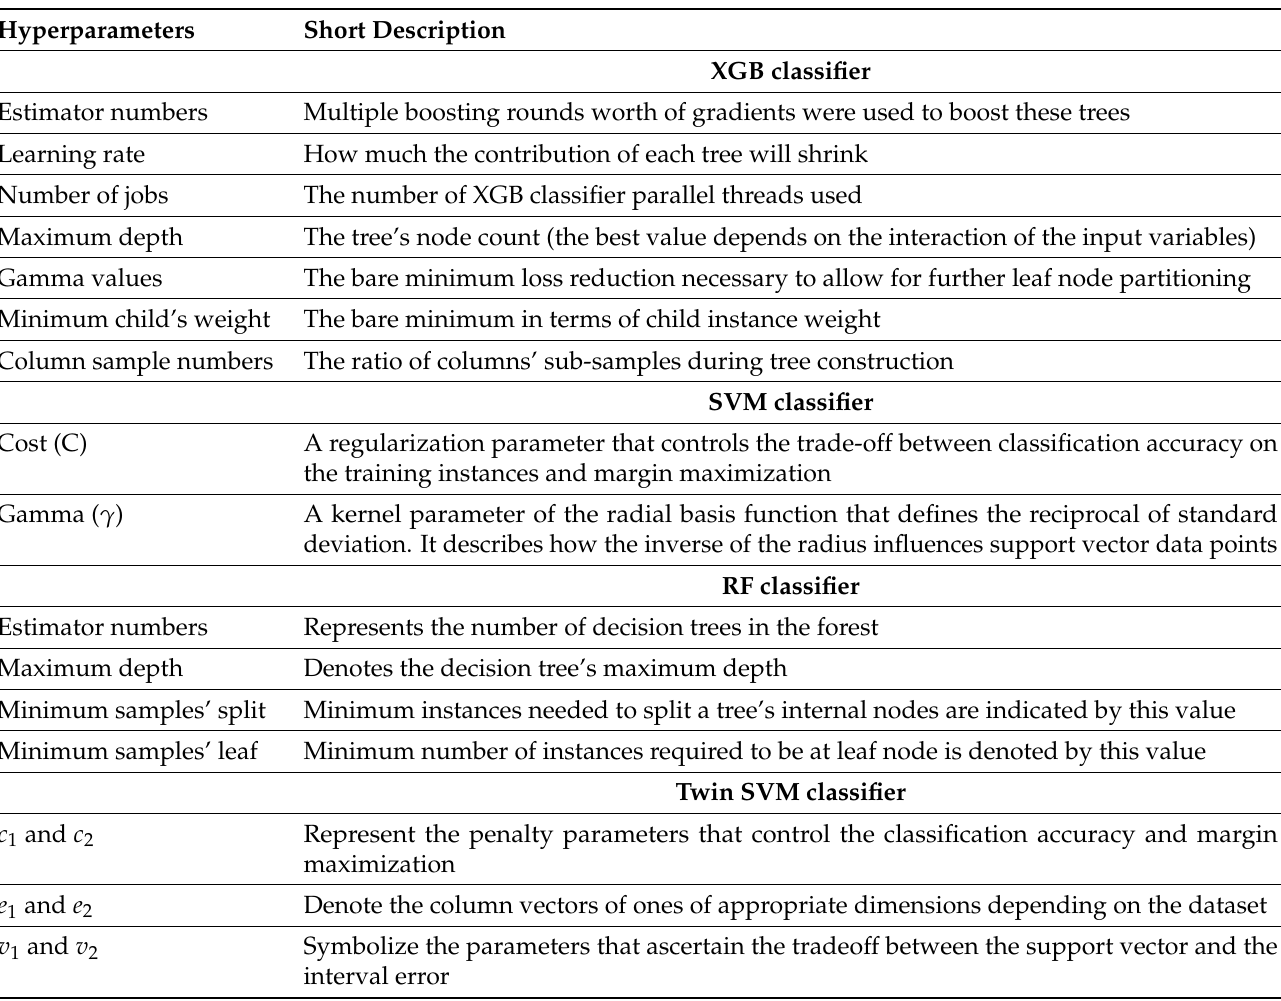
Table 1. Hyperparameters of various ML-based classifiers to be